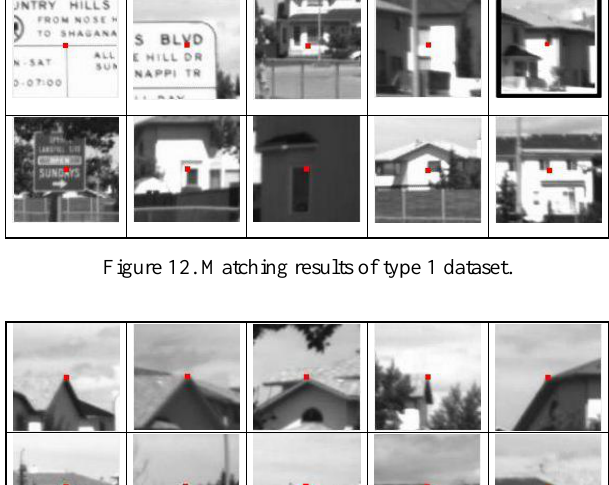
Figure 10. Result of object-space matching (The coordinates of the determinate point and the correlation coefficient).